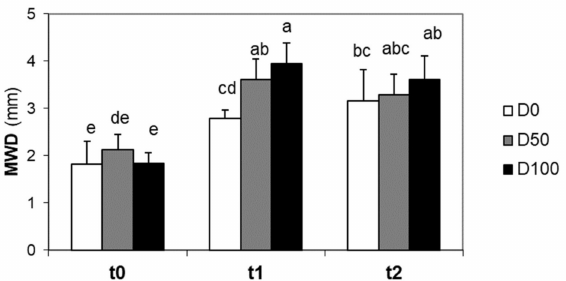
Figure 3. Soil aggregate stability as expressed by the mean weight diameter index (MWD; mm), under the different treatments and at the different sampling times. Different letters indicate statistically significant differences between treatments and sampling times at p ≤ 0.05 (Fisher LSD test).